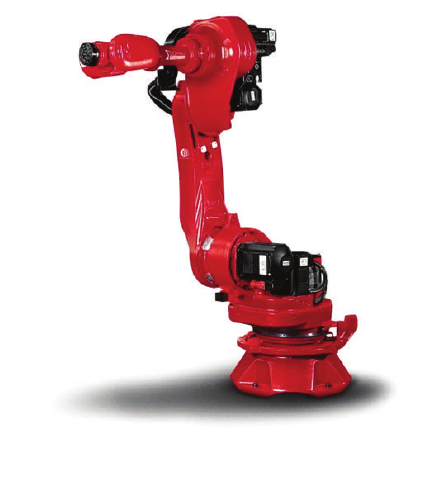
Figure 11: The SMART NS16 industrial robot